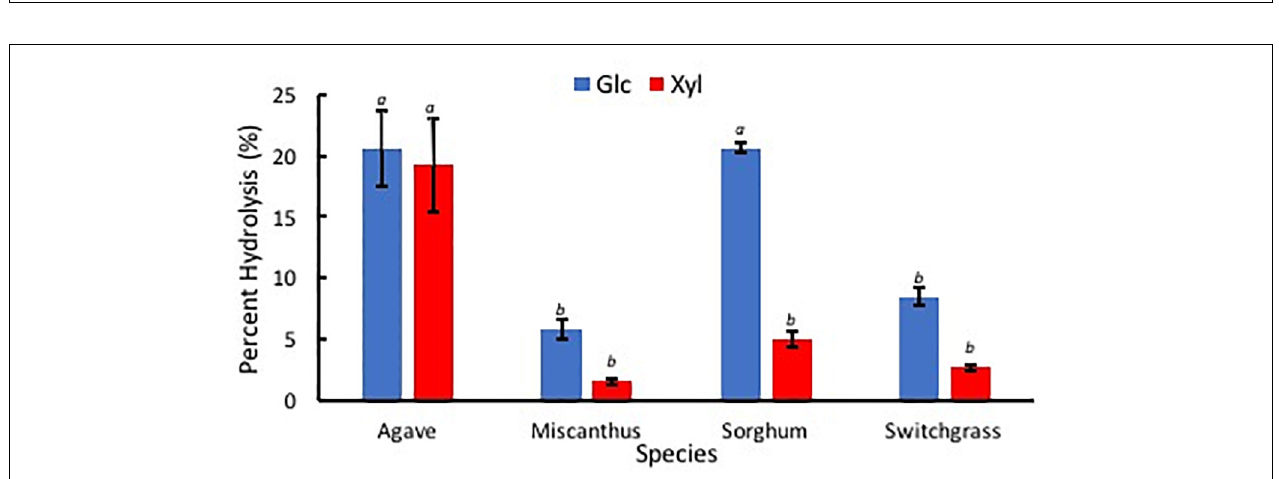
FIGURE 8 | Sugars Glc (blue) and Xyl (red) released from low solids loading enzymatic hydrolysis, expressed in mg, for each of the four species A. americana (Agave), miscanthus, sorghum, and switchgrass. Error bars indicate standard error; n = 3. Lowercase italic letters indicate significant differences between species by sugar type as per Tukey’s HSD test ( p < 0.05).